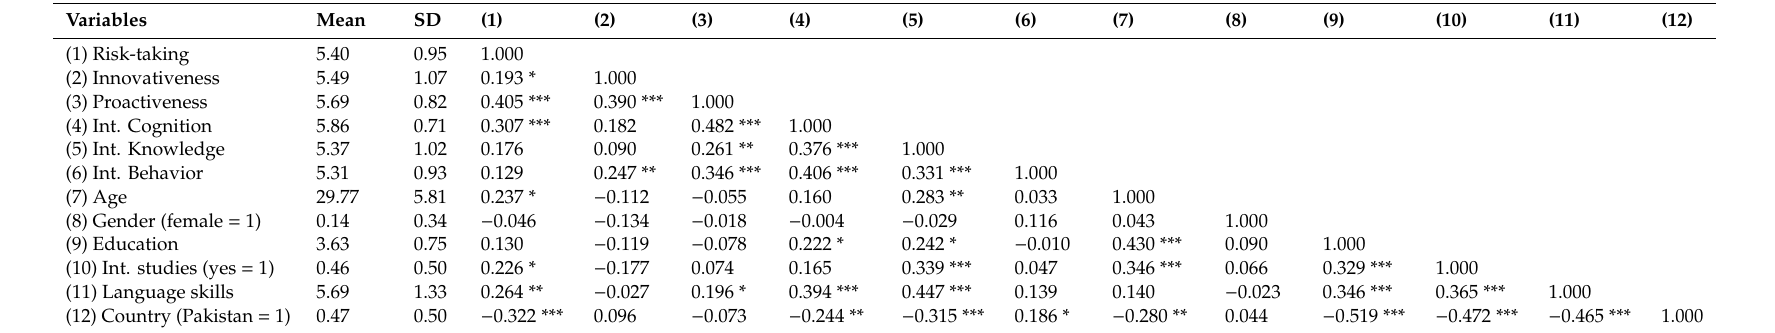
Table 1. Correlations and descriptive statistics of measurement